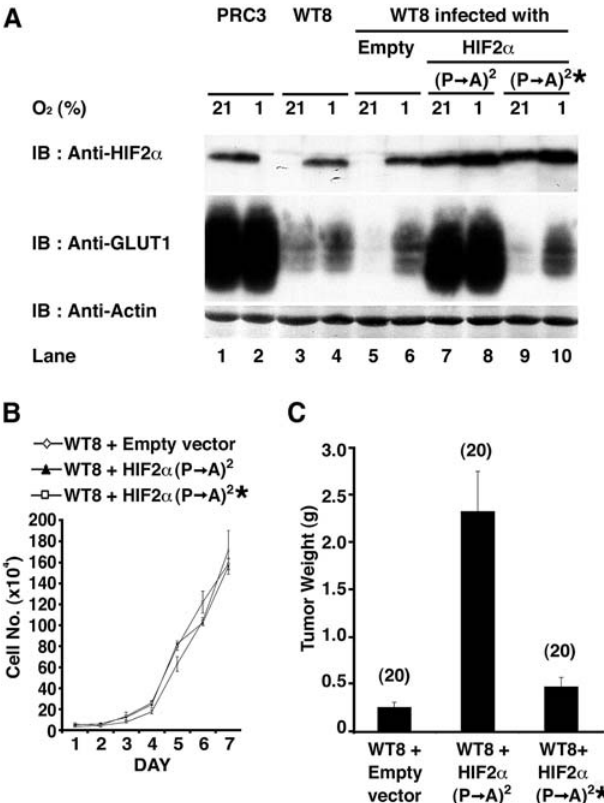
Figure 1. HIF2 a Overrides Tumor Suppression by pVHL (A) 786-O subclones that were transfected to produce wild-type pVHL (WT8) or with an empty plasmid (PRC3) cells, as well as WT8 cells infected with an empty retrovirus (Empty) or retroviruses encoding the indicated HIF2 a variants [ (P ! A) 2 ¼ P405A;P531A and * ¼ bHLH mutation] were grown in the presence of 21% or 1% oxygen and immunoblotted (IB) with the indicated antibodies. (B) In vitro proliferation of WT8 cells infected with the indicated retroviruses. (C) Tumor weights approximately 9 wk after subcutaneous implanta- tion of WT8 cells infected with the indicated retroviruses in nude mice. Number of tumors analyzed is shown in parentheses. Error bars ¼ one standard